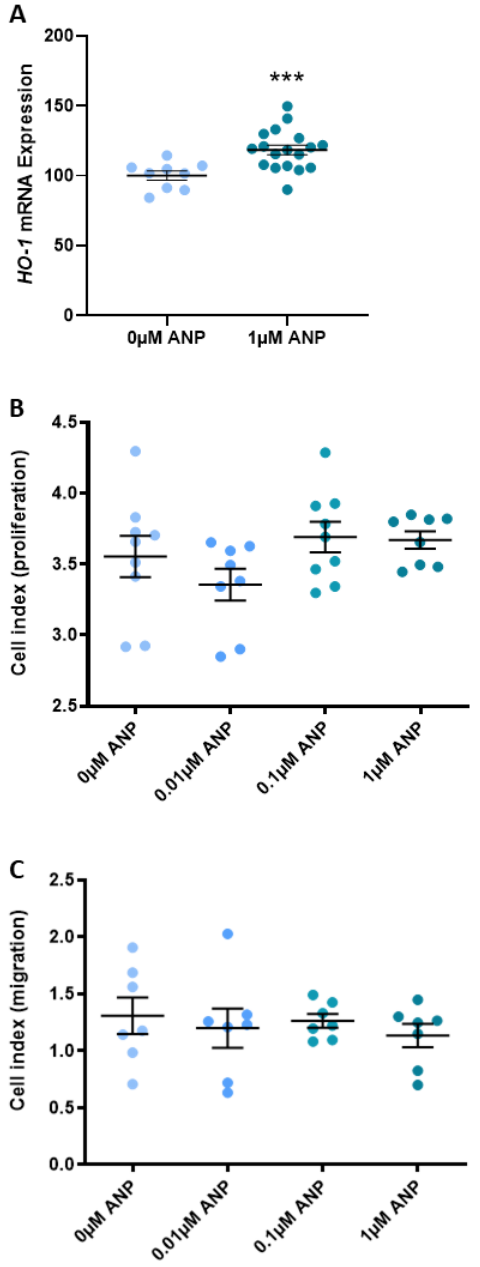
Figure 5. ANP increases HO-1 expression but does not affect HUVEC proliferation or migration. In isolated primary HUVEC, 1 µ M ANP significantly increases HO-1 mRNA expression compared to 0 µ M ANP control ( A ). Incrementally increasing doses of ANP did not affect HUVEC proliferation ( B ) or migration ( C ) compared to 0 µM ANP control. Data are mean ± SEM, n = 7–9, *** p < 0.001. In a model of endothelial dysfunction, TNF α signi fi cantly increased the expression of vascular cell adhesion molecule ( VCAM)1 mRNA ( p < 0.0001; Figure 6A) and signi fi cantly decreased the expression of NPR1 mRNA ( p < 0.001; Figure 6B) in primary HUVEC. Incrementally increasing doses of ANP did not mitigate the TNF α -induced change in VCAM1 or NPR1 mRNA expression (Figure 6A,B, respectively).